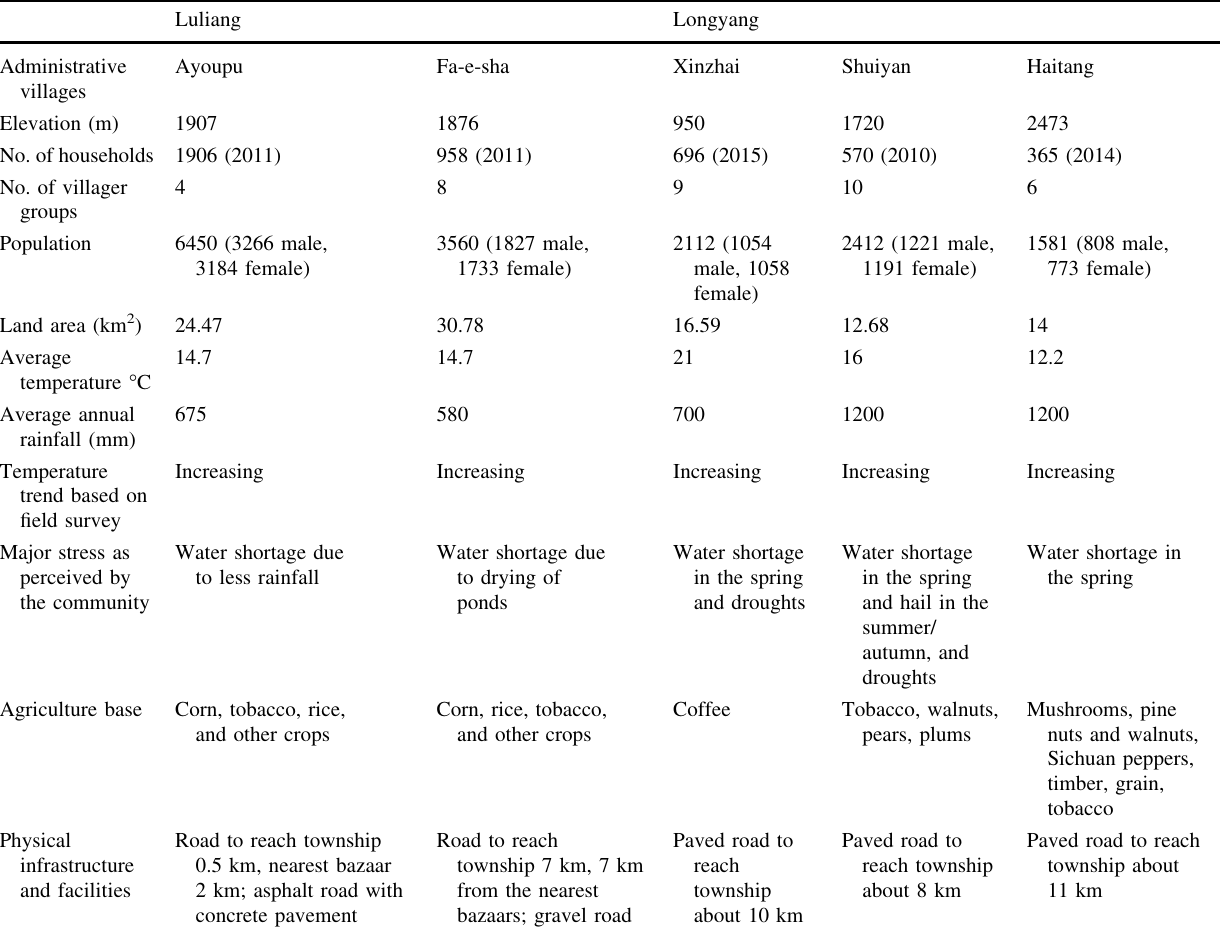
Table 1 Characteristics of the study sites in Yunnan Province, China. Source http://www.luliang.gov.cn/ (unofficial translation); Xinzhai: http:// www.ynszxc.gov.cn/S1/S1364/S1365/S1778/S12707/; Haitang: http://www.ynszxc.gov.cn/S1/S1364/S1365/S1382/S112367/; Shuiyan: